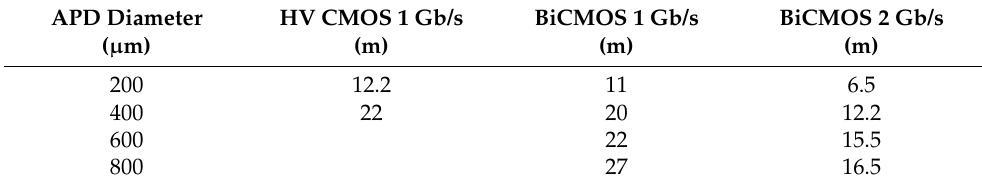
Table 1. Transmission distances of integrated APD receivers for BER < 10 − 9